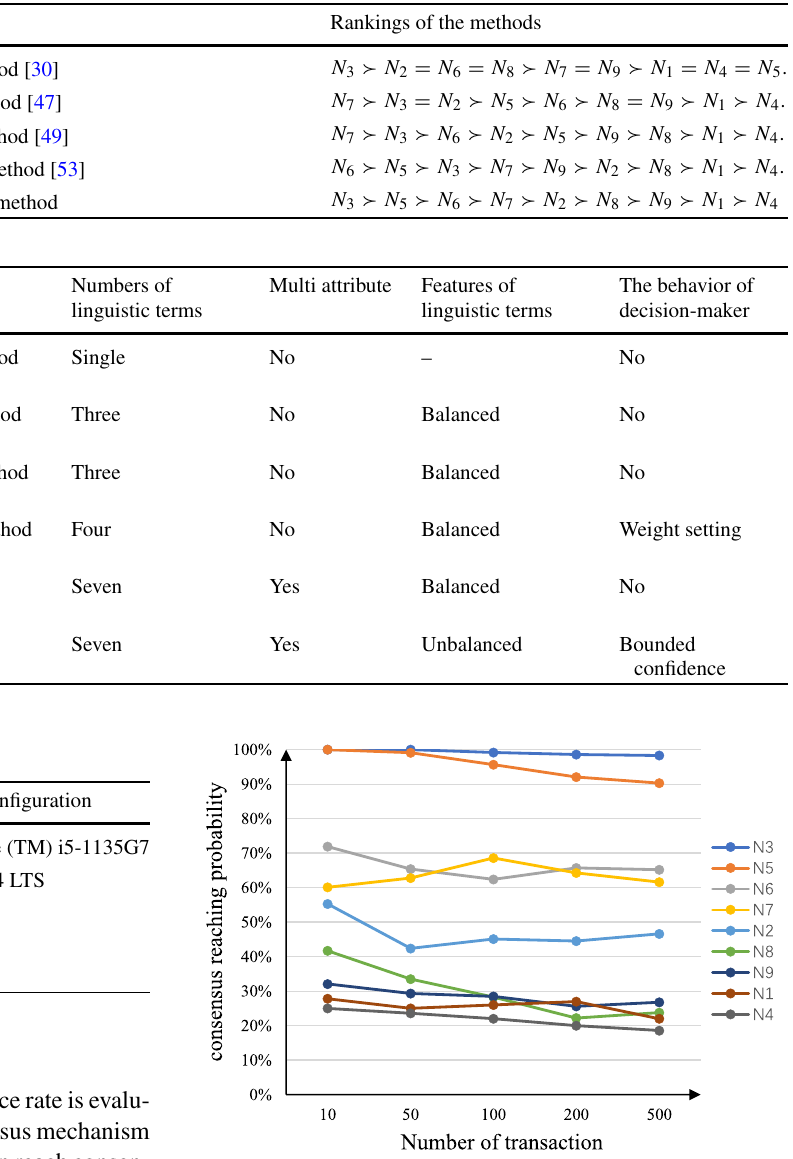
Fig. 4 Comparisons on consensus reaching of the nine